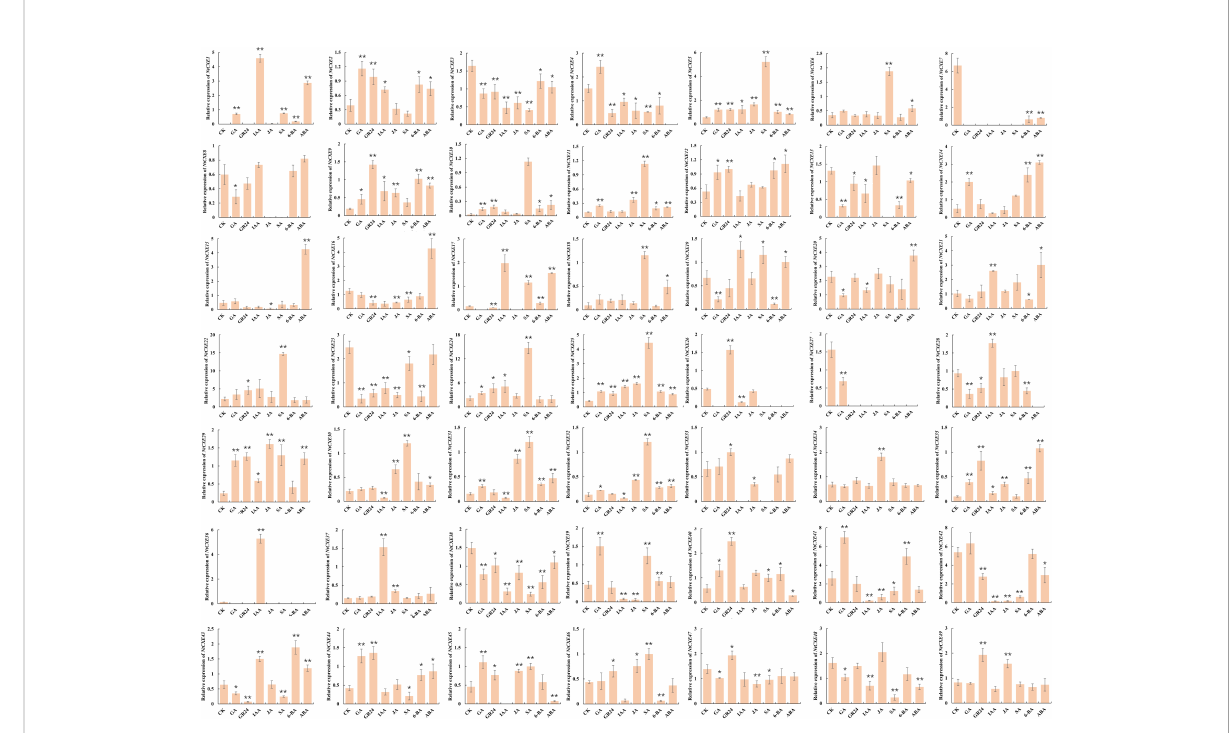
FIGURE 7 Expression pro fi les of 49 NtCXE genes under diverse hormone treatments. The expression patterns of all NtCXE genes in response to ABA, 6-BA, GA, GR24, IAA, SA, and JA were analyzed by qRT-PCR. Seedlings grown under normal conditions were used as controls. Data are presented as means ± SDs (n = 3). *P < 0.05, **P < 0.01 (signi fi cant difference between the hormone treatment and control, based on Student ’ s